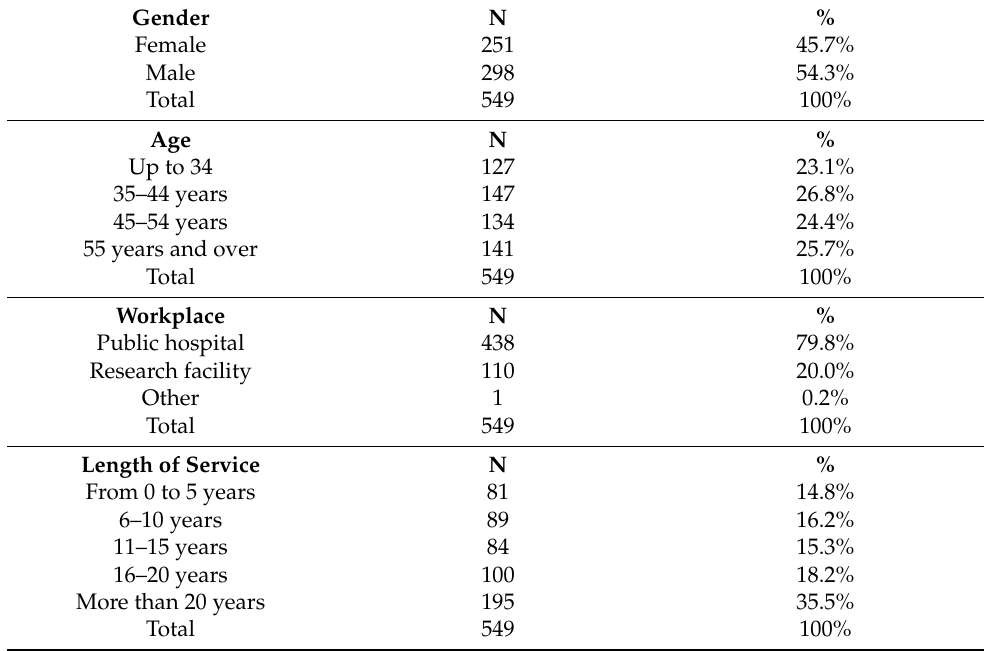
Table 1. Sociodemographic